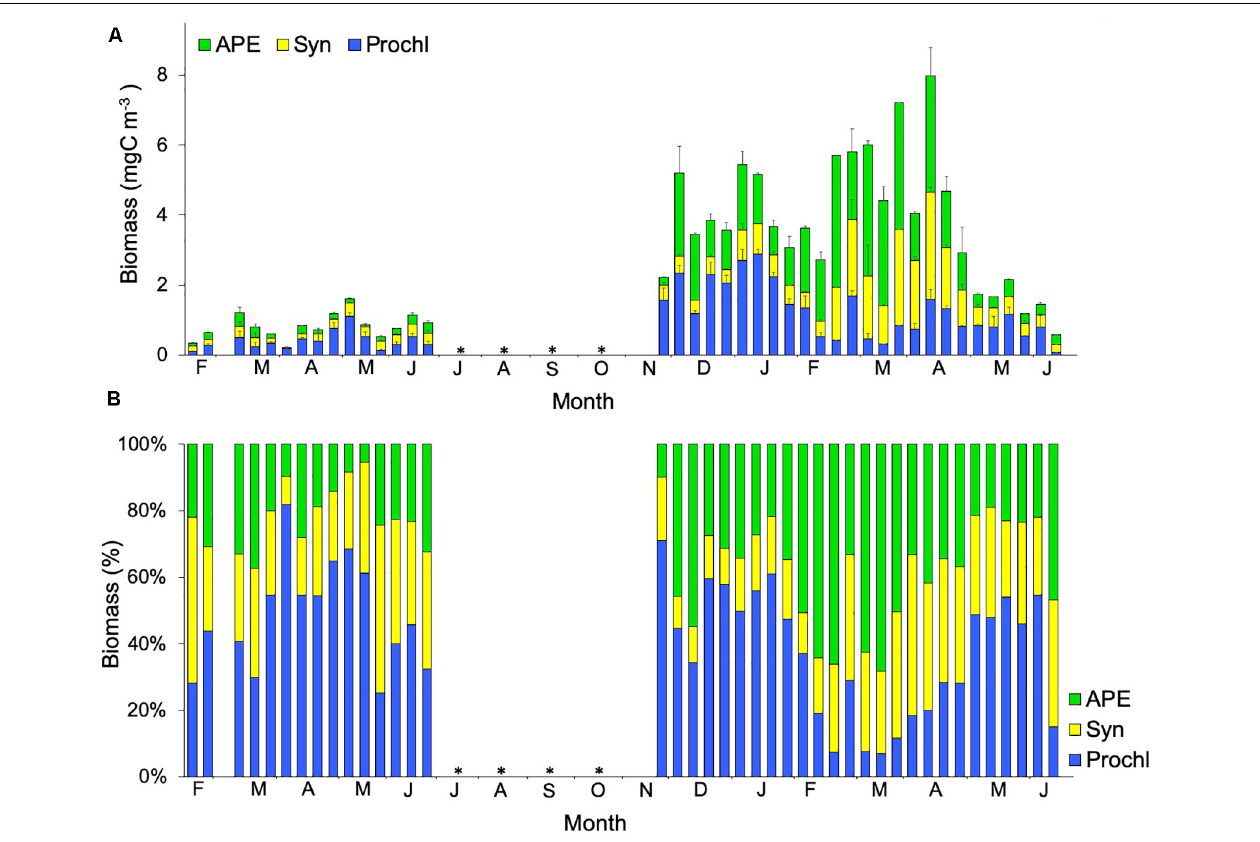
FIGURE 4 | (A) Temporal variability of average values (mean ± SE) of biomass for stations 1, 2, and 3, and (B) Percentage for Prochlorococcus (Prochl, (cid:4) ), Synechococcus (Syn, (cid:4) ), and autotrophic picoeukaryotes (APE, (cid:4) ). * No data available.